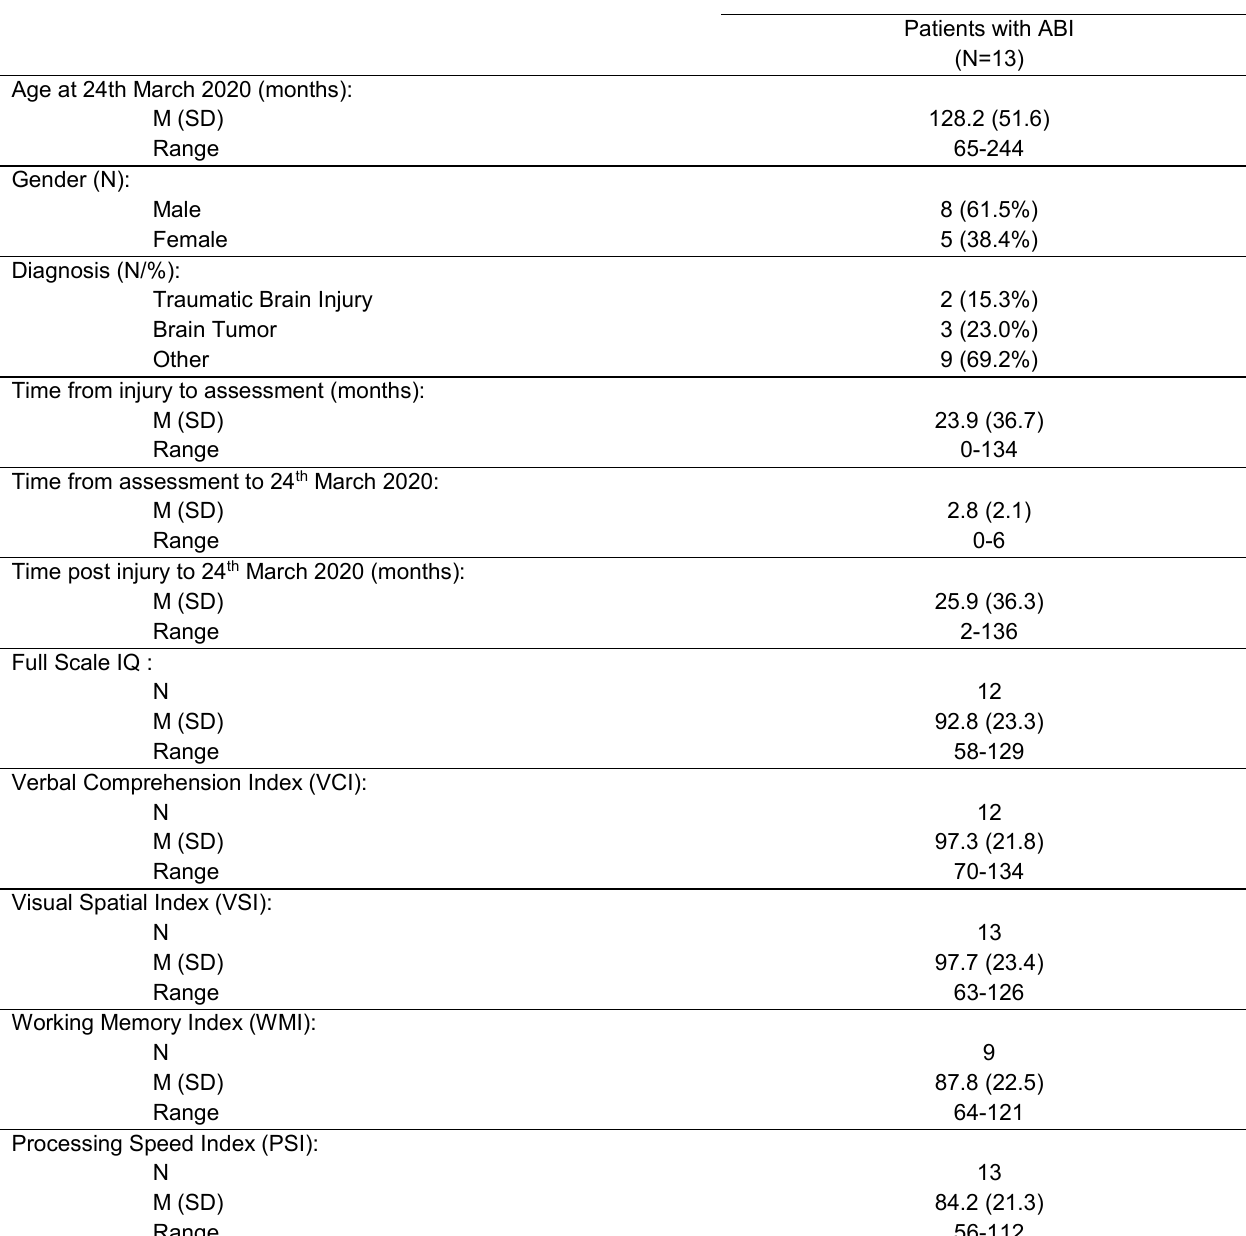
Patient Clinical Data